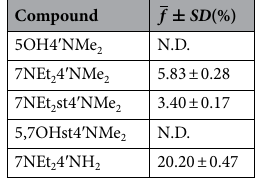
Table 2. Quantum yields of fluorescence (Φ f ) for the different compounds determined by absolute method using an integrating sphere.